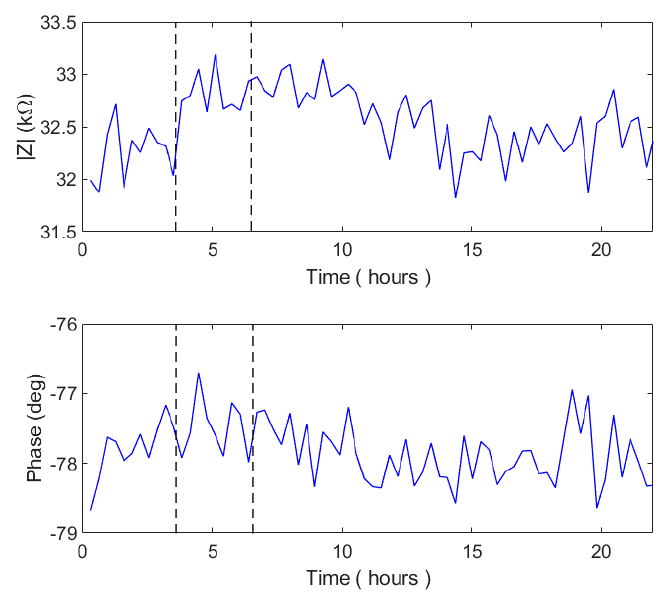
Figure 12. Module and phase impedance values measured on MEA devices at 100 mHz. The dashed lines indicate the Lactococcus lactis (4 h) and phage (7 h) inoculation moments.